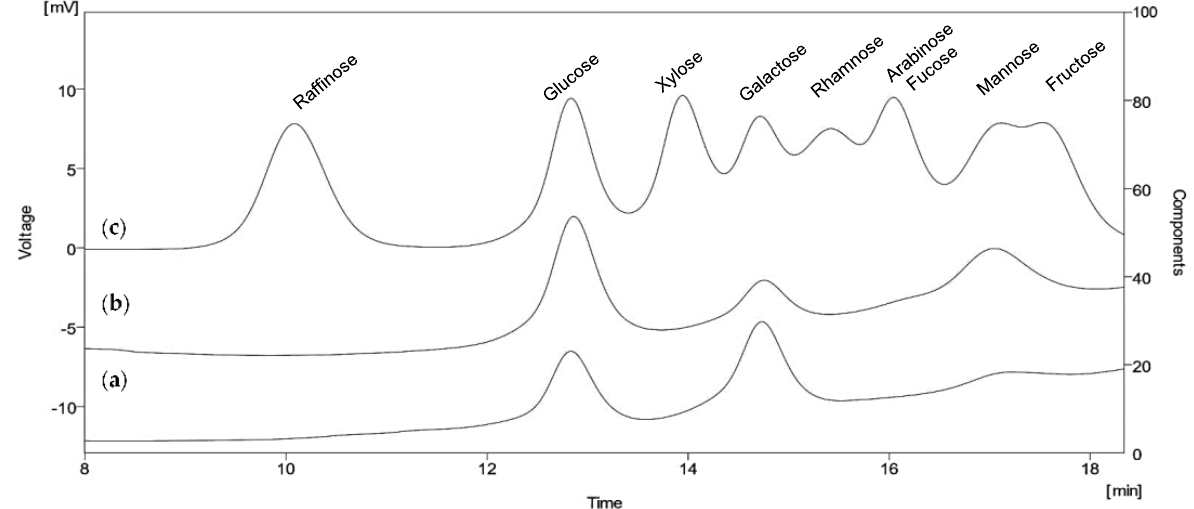
Figure 3. HPLC profiles of monosaccharide content of acid-hydrolysed EPSs produced by B. licheniformis 24. The sugars were separated by Aminex HPX-87P column and detected by RI detector. ( a ) Sugar profile of EPS1 produced from glucose; ( b ) Sugar profile of EPS2 produced from fructose; ( c ) Referent sugar standards.